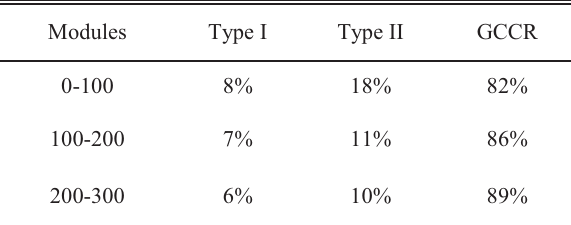
Table 5. Accuracy rate of low, medium and high fault prone prediction on